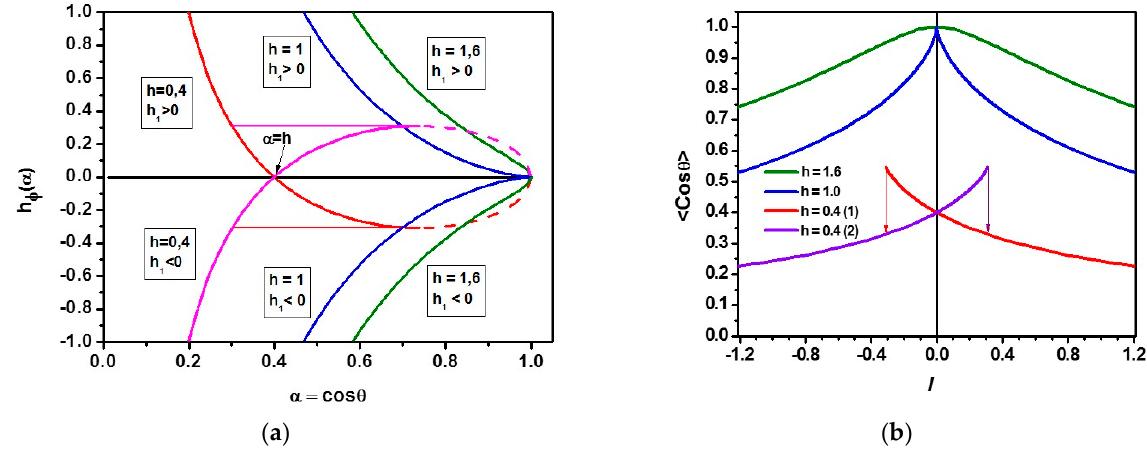
Figure 2. Set of equilibrium curves calculated for three values of the dimensionless longitudinal magnetic field: h = 0.4 (red/purple curves), h = 1.0 (blue curves), and h = 1.6 (green curves). ( a ) Local curves of equilibrium h ϕ ( α ). ( b ) The dependence of the average magnetic flux on the dimensionless exciting current applied to the microwire.